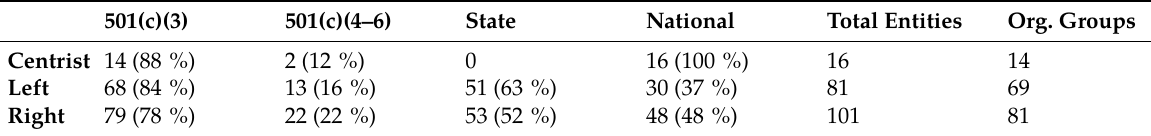
Table 2: Think tank nonprofit status and geographical emphasis by political lean.